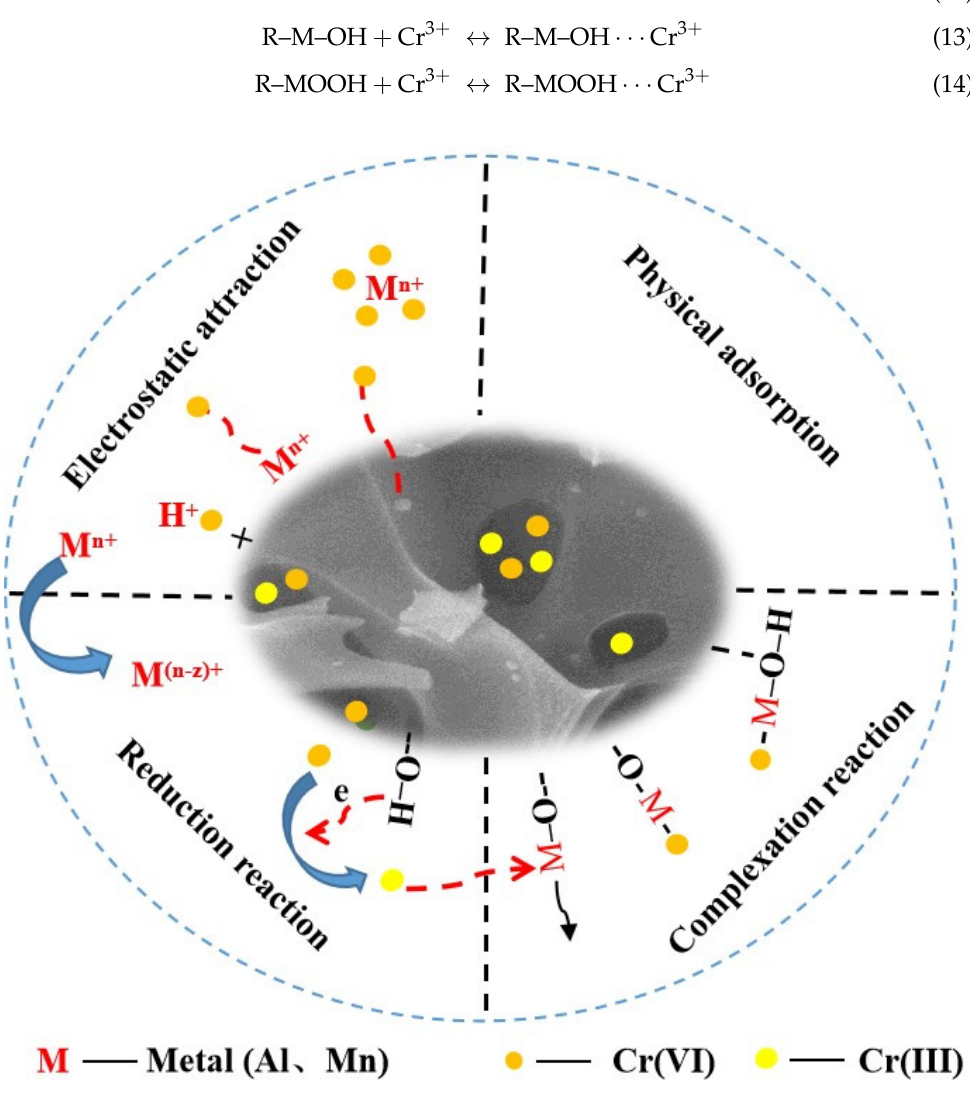
Figure 8. Cr(VI) removal mechanism of AMKBC 3/4 .